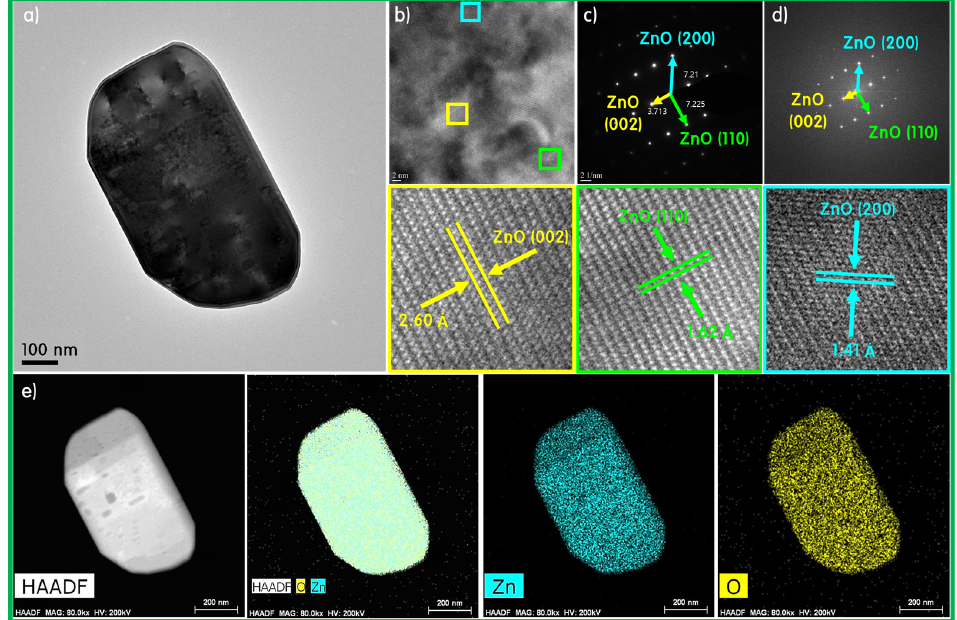
Figure 2. ( a ) HRTEM image of the obtained ZnO nanoplates; ( b – d ) SAED pattern and corresponding identified lattice fringes associated with ZnO.; ( e ) HAADF image as well as elemental mapping of the ZnO nanoplates .